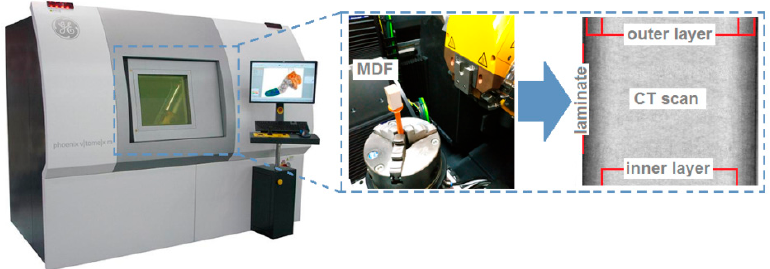
Figure 1. MDF density measurement on a computer tomography Phoenix v|tome|x m.